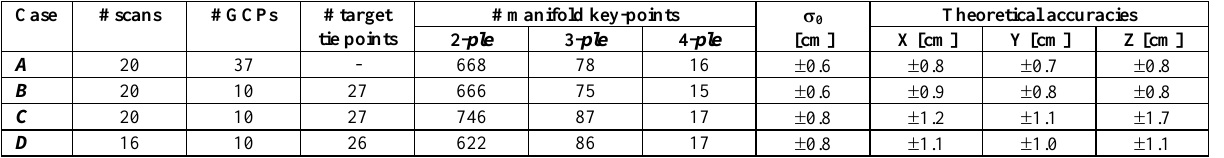
Table 4. Parameters of the blocks used to test the registration method based on ‘pano-RGB’ and related results. In the column ‘target tie points’ is reported the number of retro-reflective targets used as additional tie points; columns ‘key-points’ refer to points automatically extracted from the ‘pano-RGB’ images